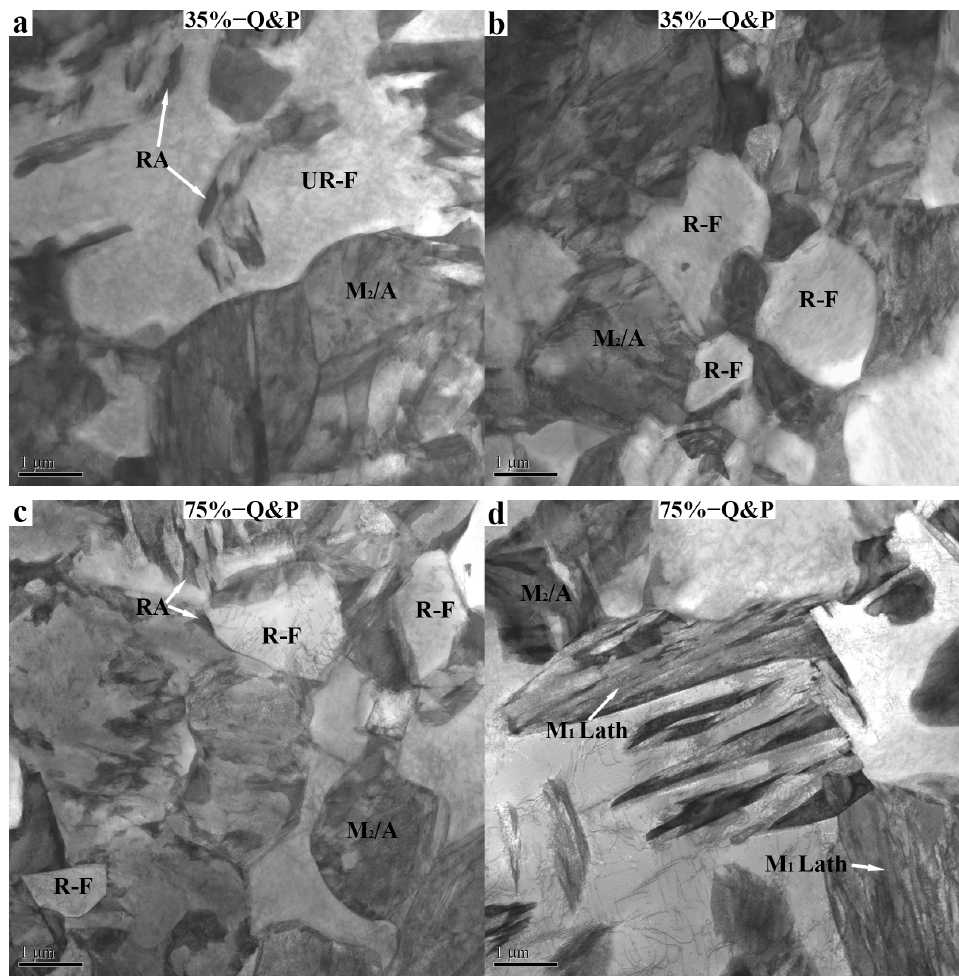
Figure 5. The TEM micrographs of ( a , b ) 35%−Q&P sample and ( c , d ) 75%−Q&P